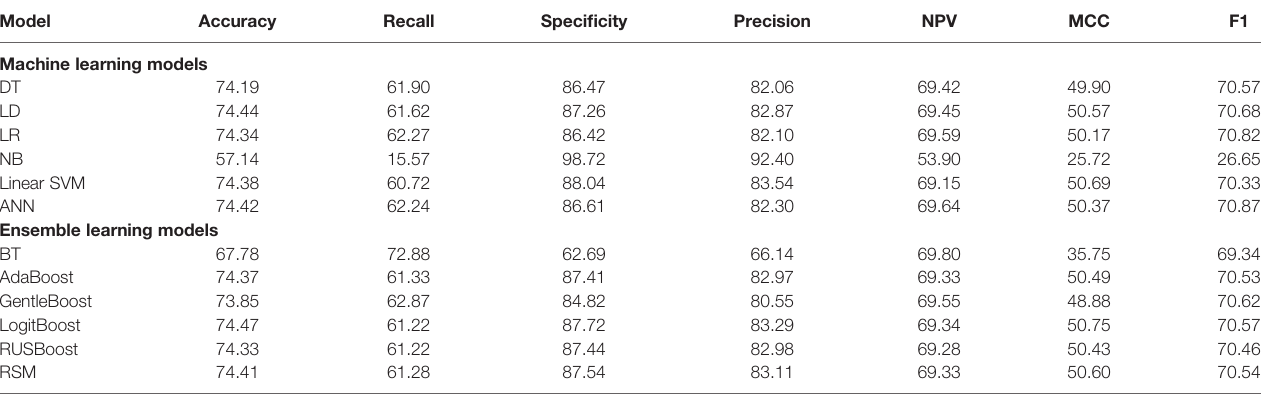
TABLE 3 | Evaluation metrics of all models.